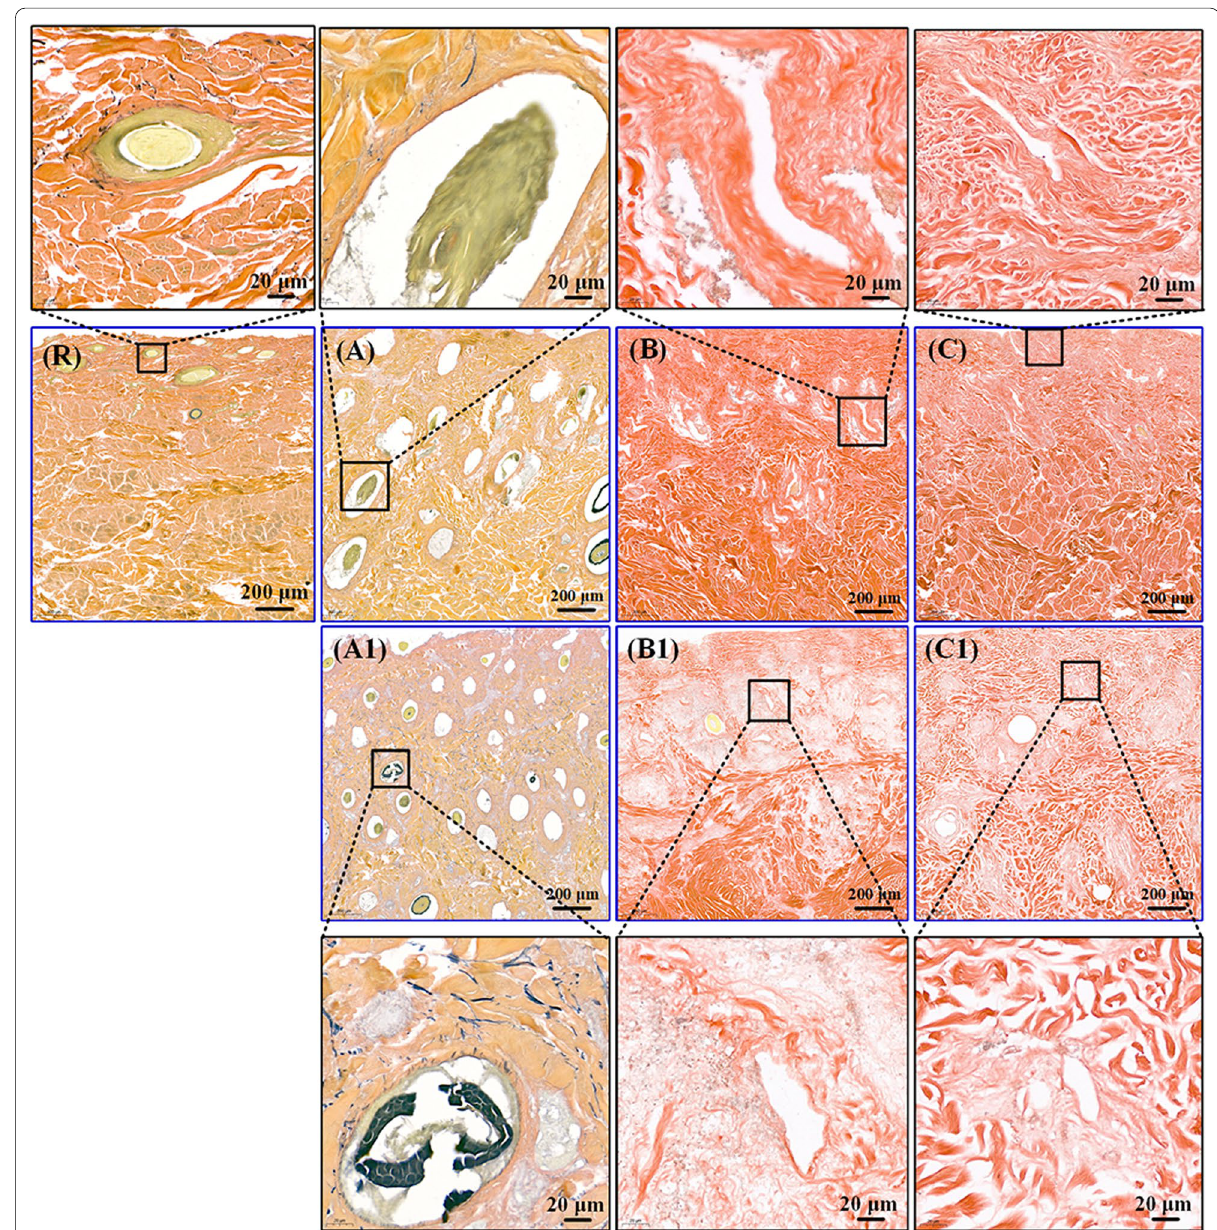
Fig. 3 Digital scanning images of EVG staining of cross-section of bovine hides after unhairing ( A – C ) and collagen fibers opening ( A1 – C1 ) by conventional ( A , A1 ) KCl-dispase ( B , B1 ) and [AMIm]Cl-dispase ( C , C1 ) processes; R, raw bovine